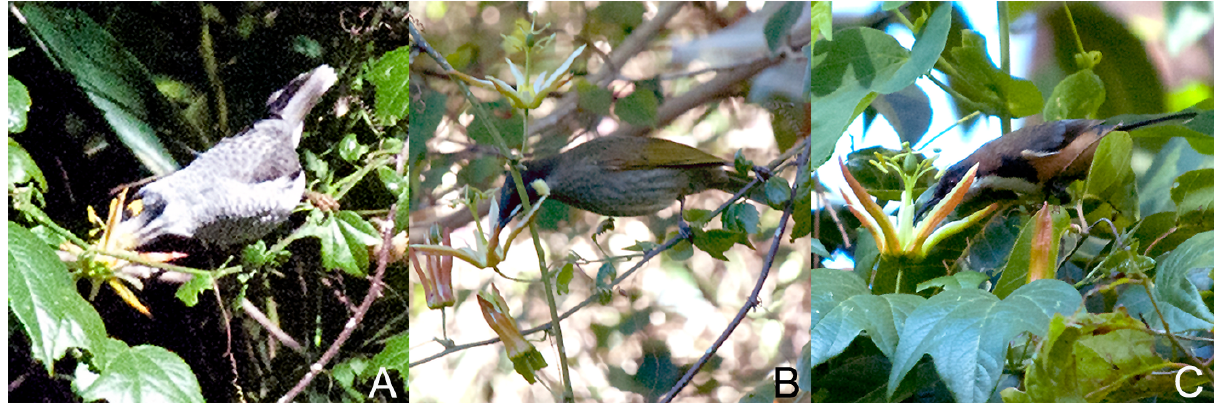
F IGURE 4. Floral visitors to Passiflora herbertiana. (A) Noisy Miner. (B) Lewin’s Honeyeater. (C) Eastern